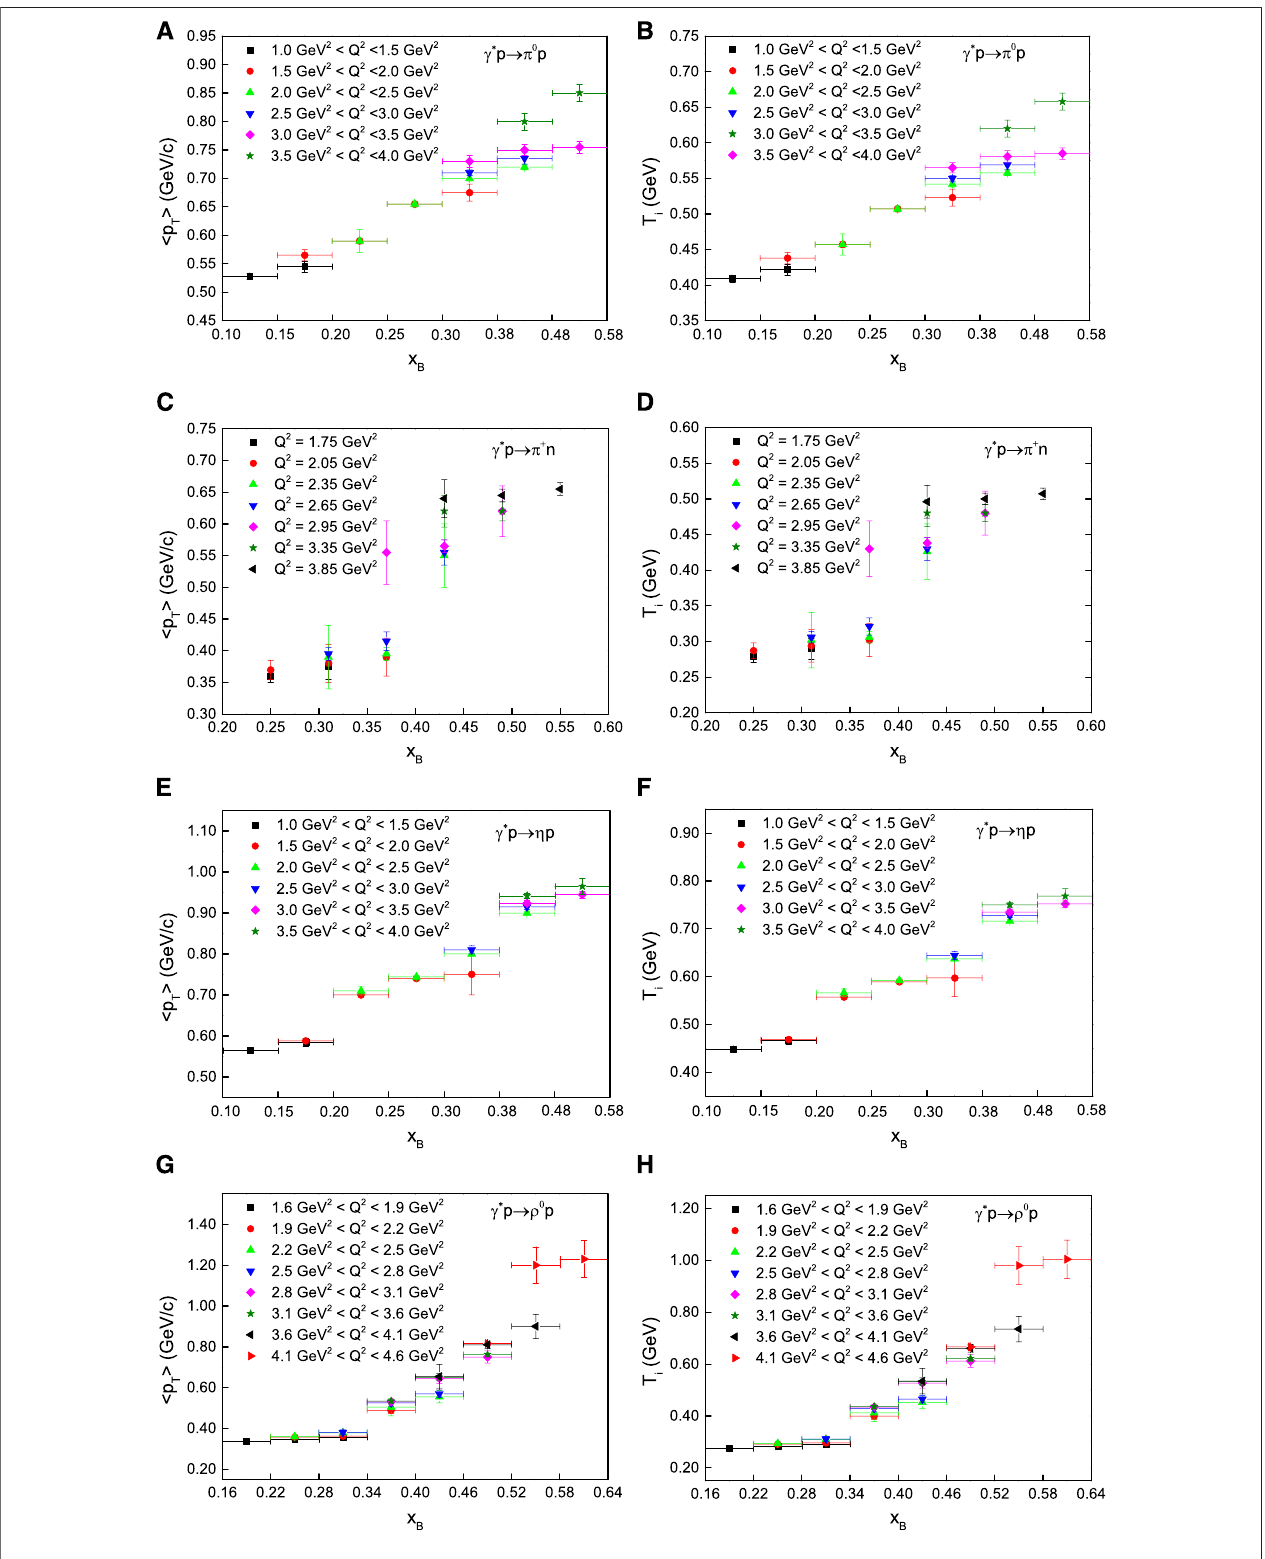
FIGURE 6 | The dependences of 〈 p T 〉 (A,C,E,G) and T i (B,D,F,H) on x B in c * p collisions with emitted channels π 0 p (A,B) , π + n (C,D) , η p (E,F) , and ρ 0 p (G,H) . Different symbols represent the results for different Q 2 .